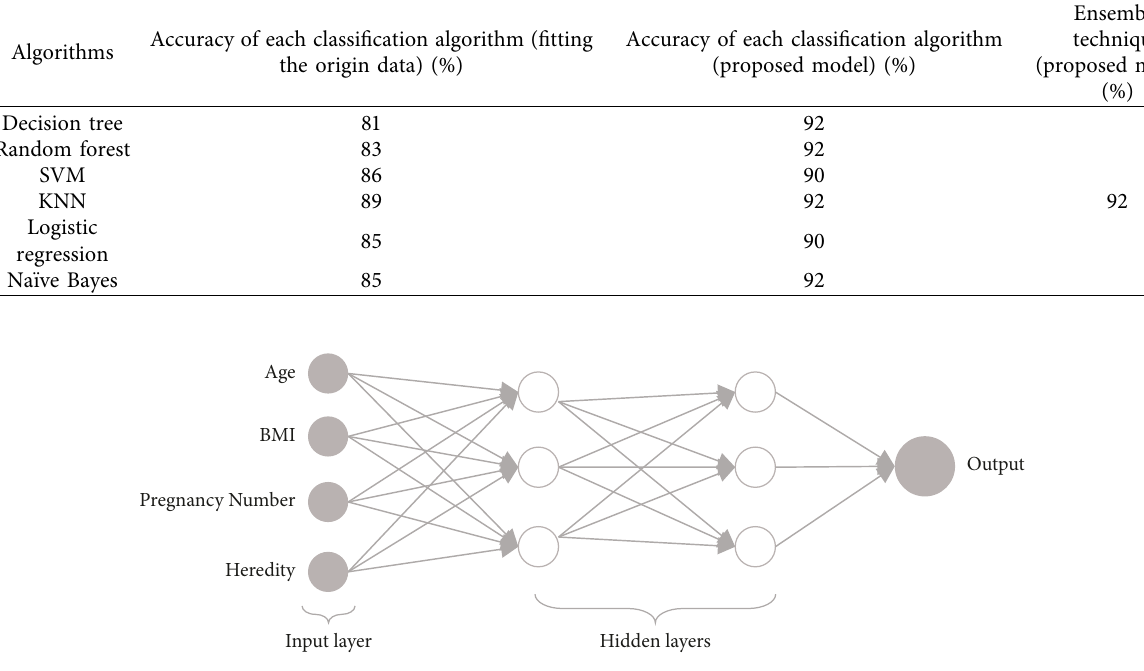
Figure 6: Artificial neural network binary classification.